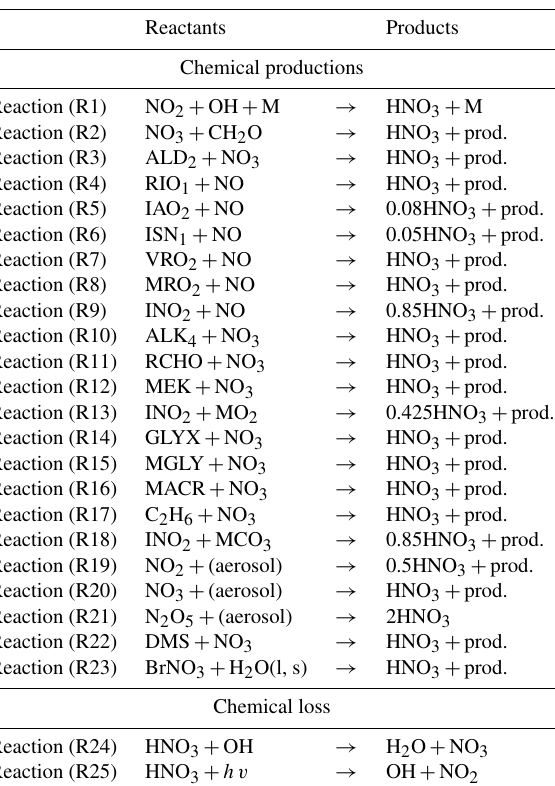
Table 3. List of gas-phase reactions and heterogeneous reactions involve HNO 3 in the GEOS-Chem model (Version